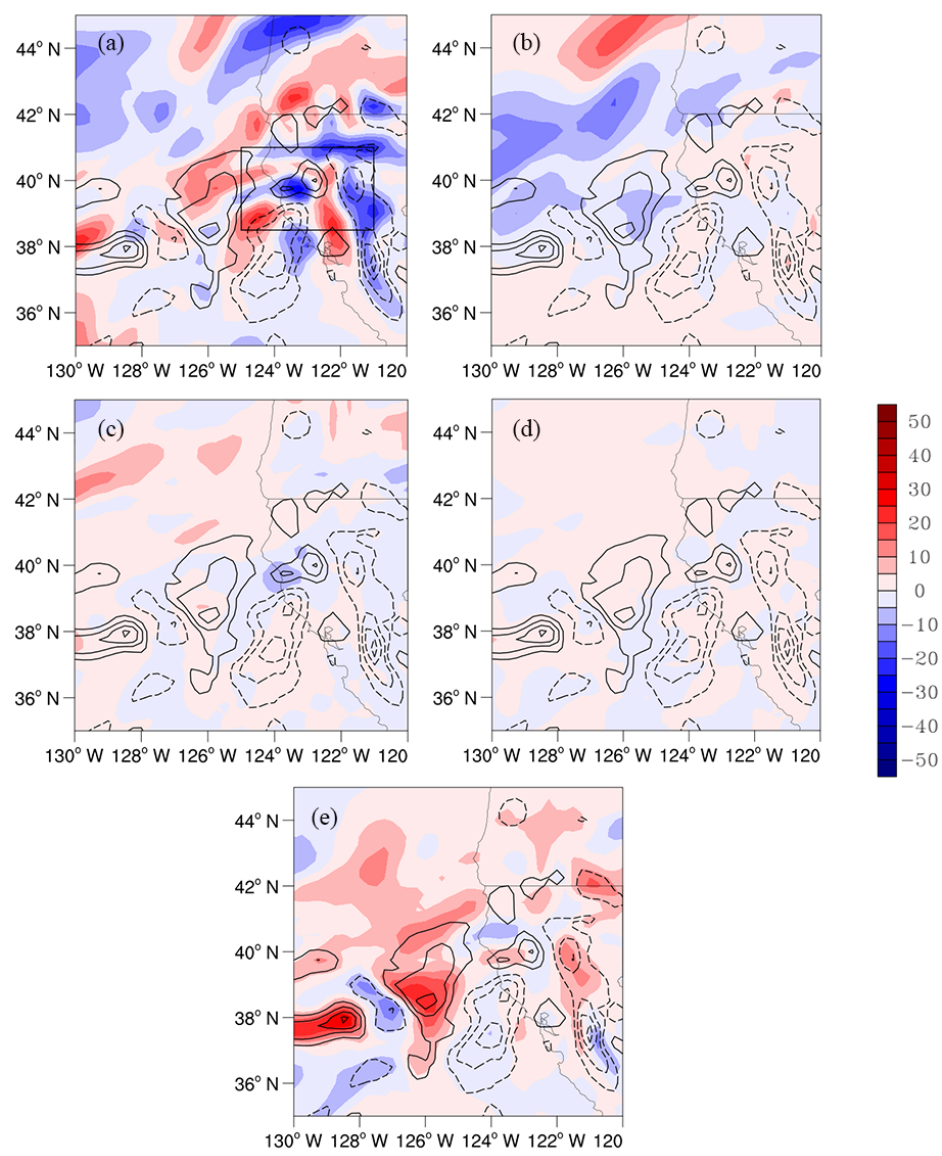
Figure 10. Maps of ( a ) Γ 0 → 2 (shadings; in 10 − 4 m 2 s − 3 ), ( b ) Γ 1 → 2 (shadings; in 10 − 4 m 2 s − 3 ), ( c ) Γ 0 → 2 (shadings; in 10 − 4 m 2 s − 3 ), ( d ) Γ 1 → 2 (shadings; in 10 − 4 m 2 s − 3 ) and ( e ) − b 2 (shadings; in 10 − 4 m 2 s − 3 ) averaged from 900 to 300 hPa on 26 February at 18:00 UTC. The box in ( a ) denotes the rainfall area during Stage II. Contours of the mesoscale vertical velocity ( − ω ∼ 2 ; in Pa/s) are superimposed with an interval of 0.2 (solid contours for the ascending